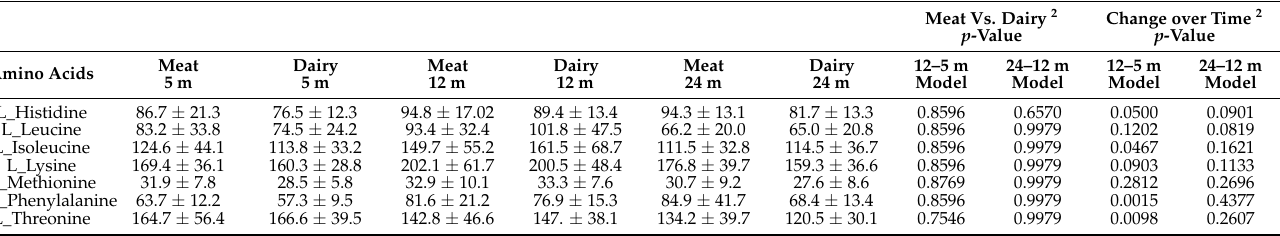
Change over Time 2 Meat Vs. Dairy 2 p -Value p -Value